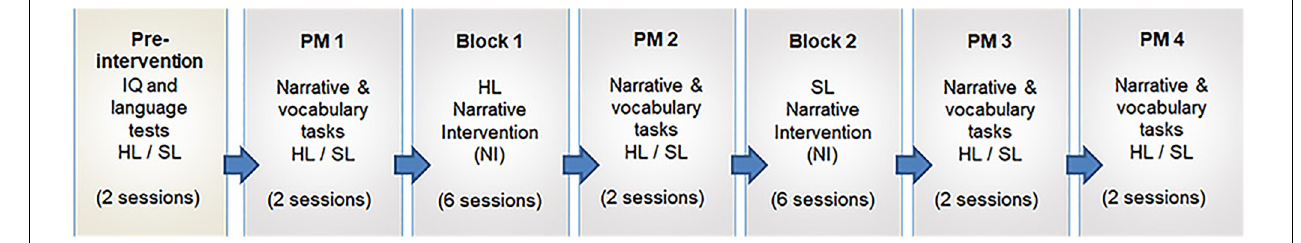
FIGURE 1 | Protocol for data